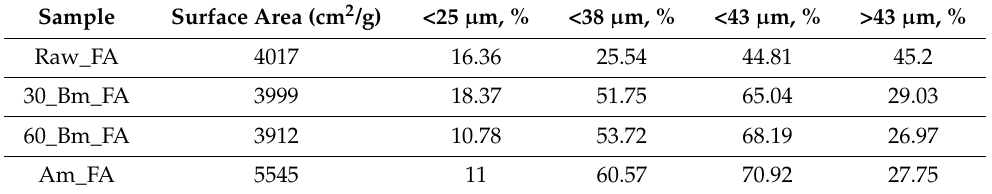
Table 1. Change in the Blaine surface area and particle size of the ball-milled and attrition-milled fly